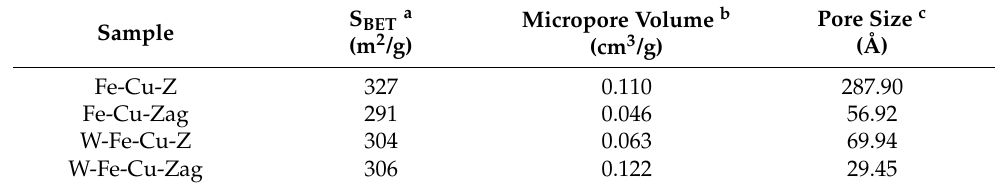
Table 2. N 2 physisorption at 77 K results.